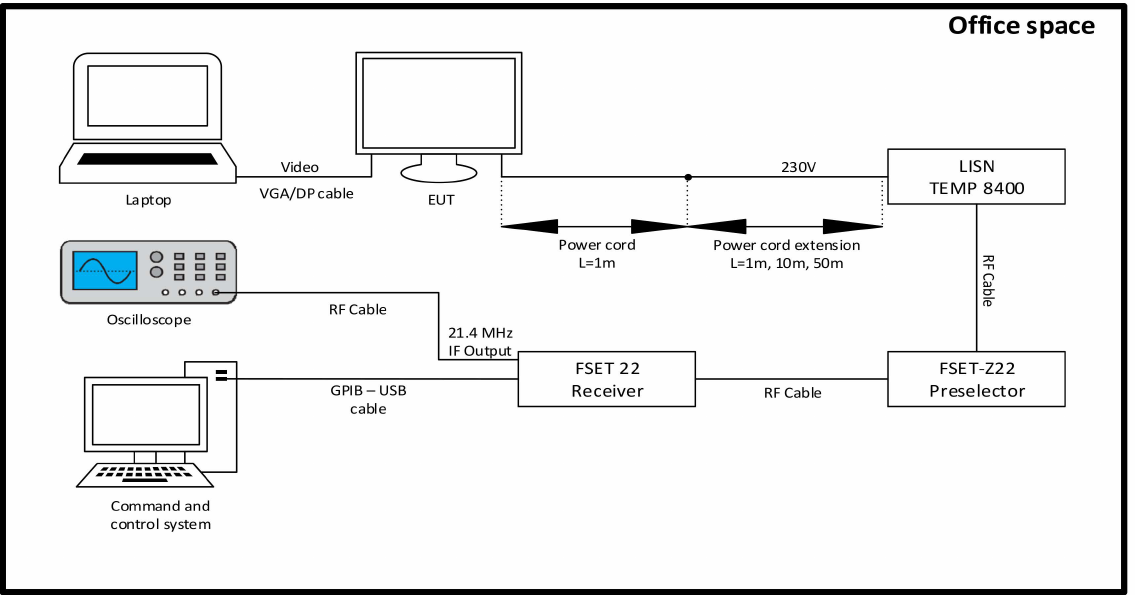
Figure 1. Measurement test